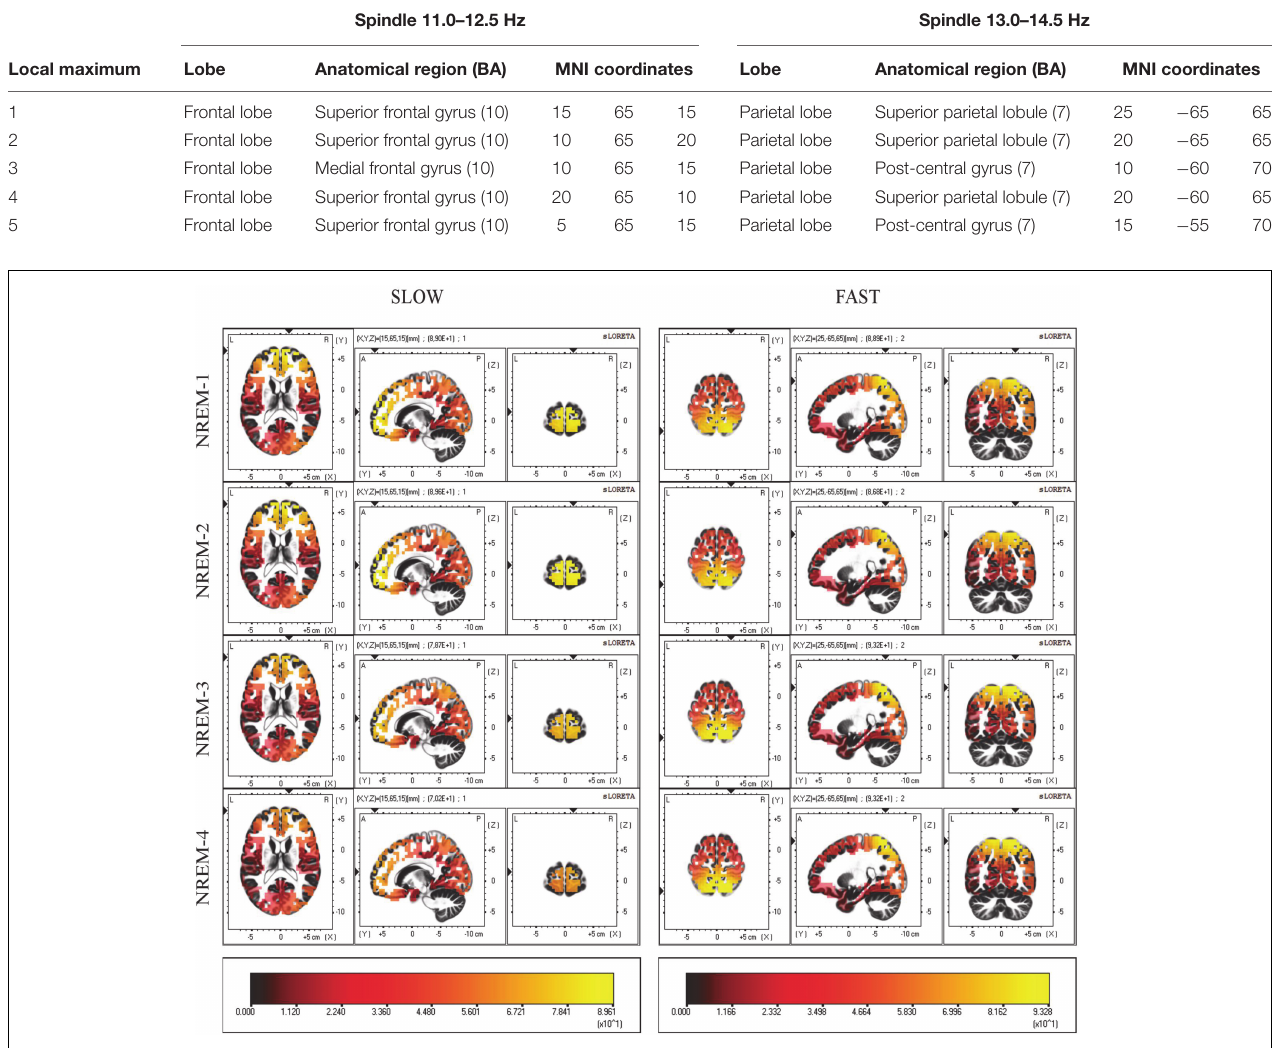
FIGURE 2 | Distribution of mean CSD of slow (11.0–12.5 Hz) and fast (13.0–14.5 Hz) spindles in the first four NREM sleep cycle. Regardless of their current intensity values, local maxima of CSD remain in the same BAs (10,7) across all cycles. Each distribution is shown relative to its maximum (in yellow), using axial, sagittal, and coronal slices intersecting at the point of maximal